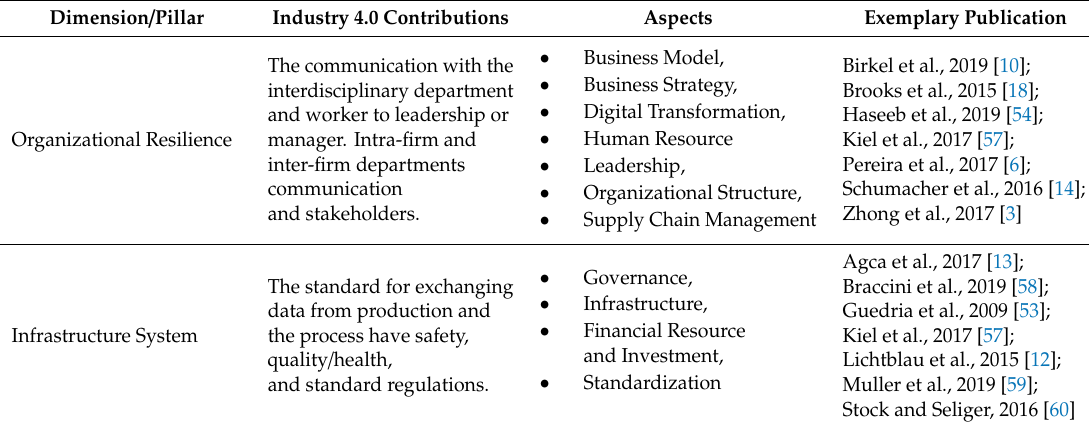
Table 5. Industry 4.0 dimension and